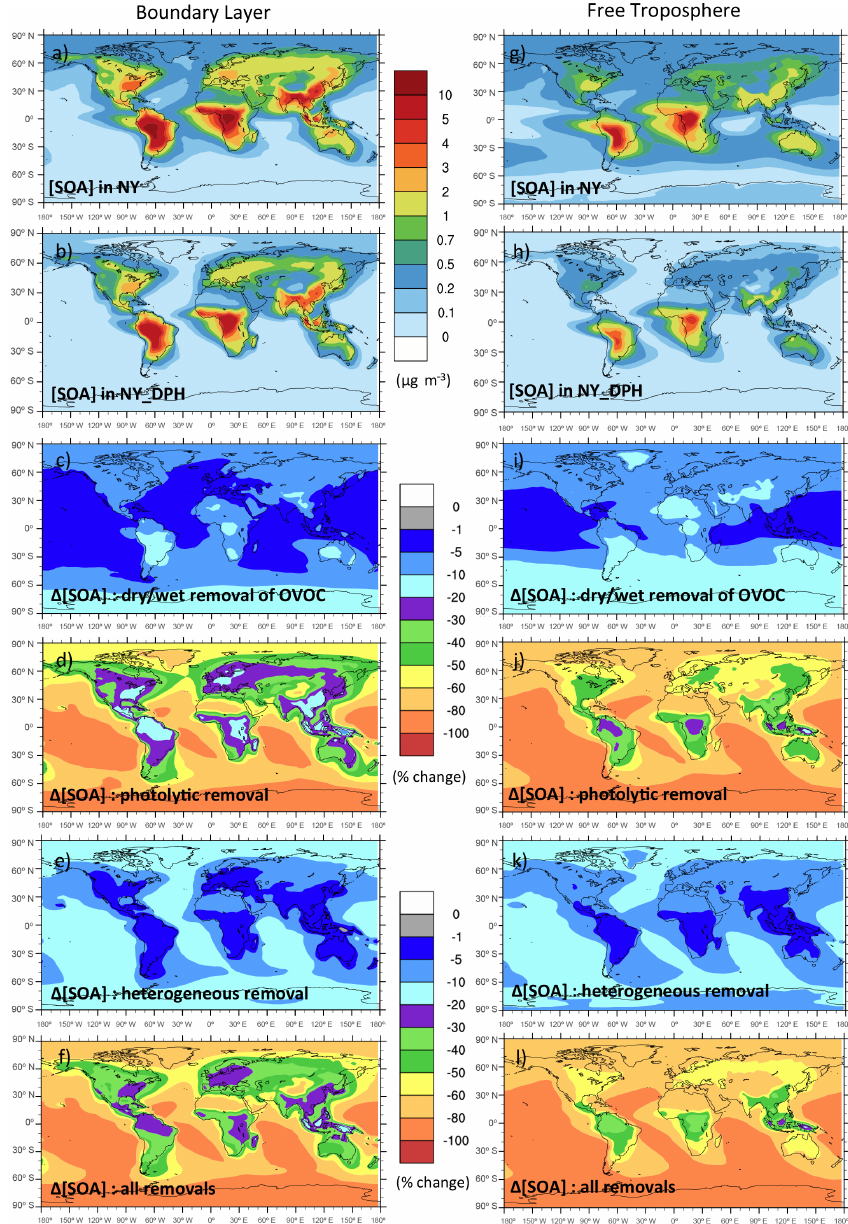
Figure 3. Average SOA concentrations for 2005–2008 as predicted by NY and NY_DPH runs in the boundary layer (surface to 1.5km; left column) and in the free troposphere (1.5–5km; right column). Percent decrease in SOA concentrations resulting from dry/wet removal ([NY_D − NY] / [NY]), photolytic removal ([NY_DP − NY_D] / [NY_D]) and heterogeneous removal ([NY_DPH − NY_DP] / [NY_DP]) of SOA. The combined effect of all considered removal pathways on SOA concentrations is also shown ([NY_DPH − NY] /